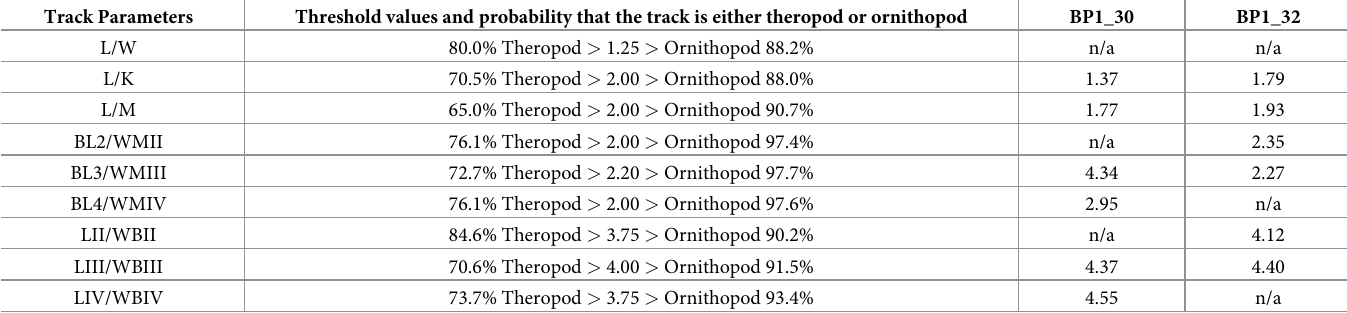
Track measurements (as outlined in Fig 2) from TA_1 were used to determine the likelihood of the track having either theropod or ornithopod affinity [42]. Both tracks demonstrated a slightly more ornithopod affinity based on whole track characteristics, while more ’digit-focused’ parameters consistently yielded a theropod affinity. The blank spaces in the table reflect parameters that are incalculable because the track was